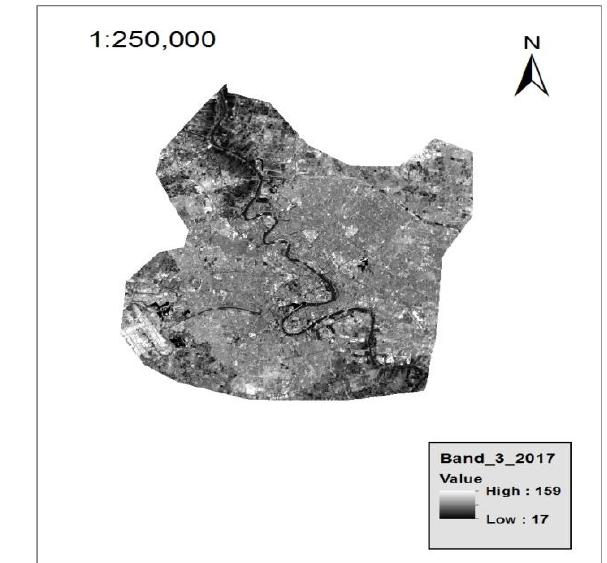
Fig.11: Show image of band (3) for study area in date (27/11/2017).